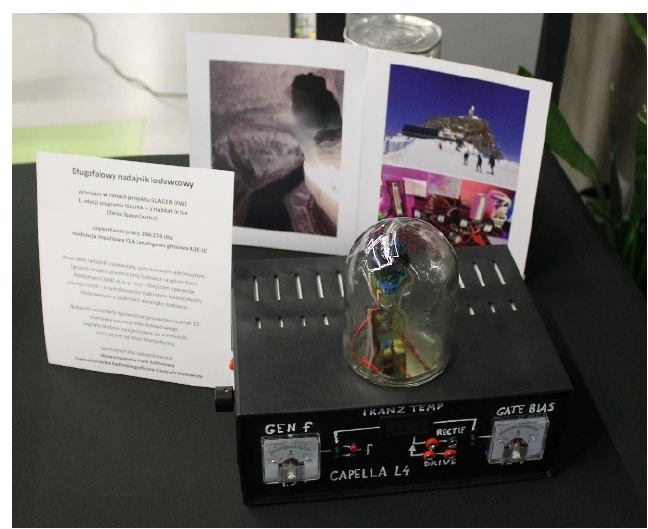
Figure 11. The first specimen of the A / C-class low frequency transmitter used in IGLUNA 2019 field campaign.